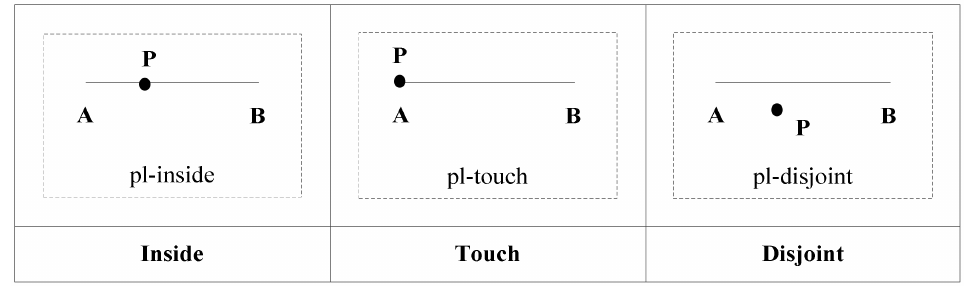
Figure 5. Topological relations between a point and a line segment.